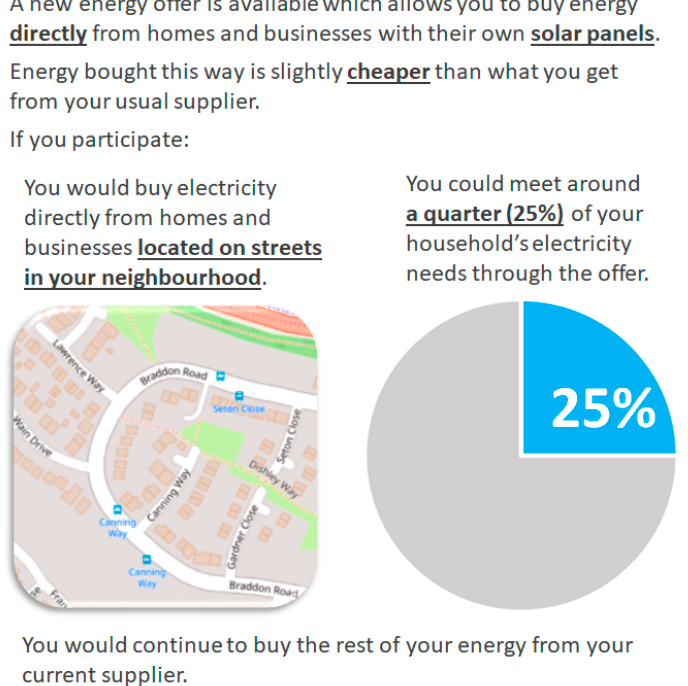
Figure 1. An example experimental scenario as it would have appeared to participants. Table 3. Analysis models.